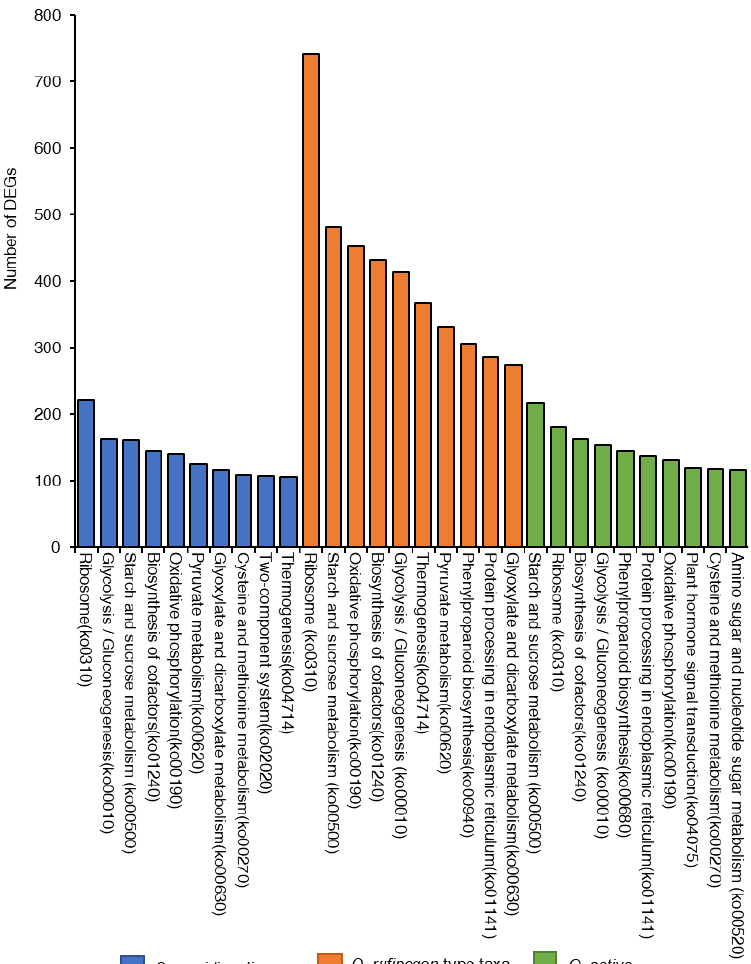
Figure 5. Top ten Kyoto Encyclopedia of Genes and Genomics (KEGG) pathways represented by the highest number of differentially expressed genes (DEGs) in O. meridionalis , O. rufipogon type taxa, and O. sativa .